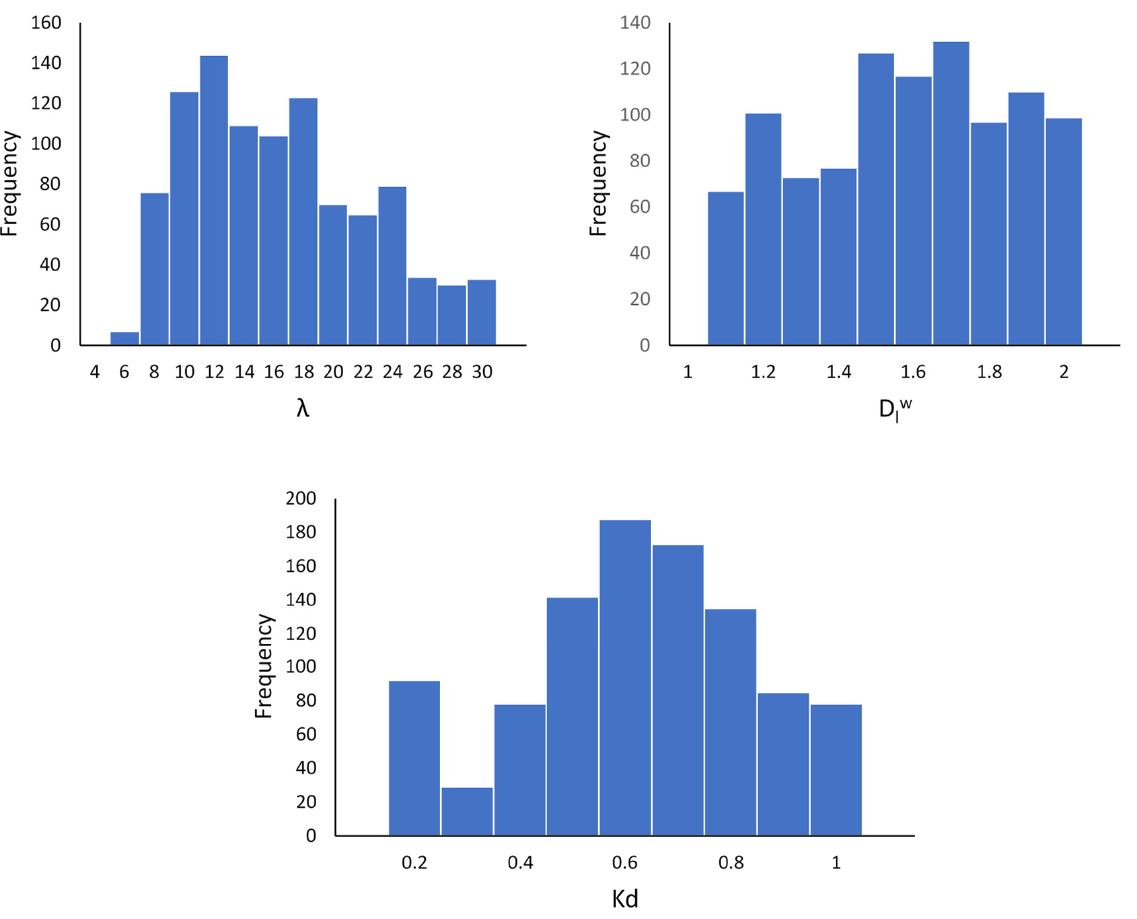
Figure 3. Posterior distributions of the solute transport parameters.